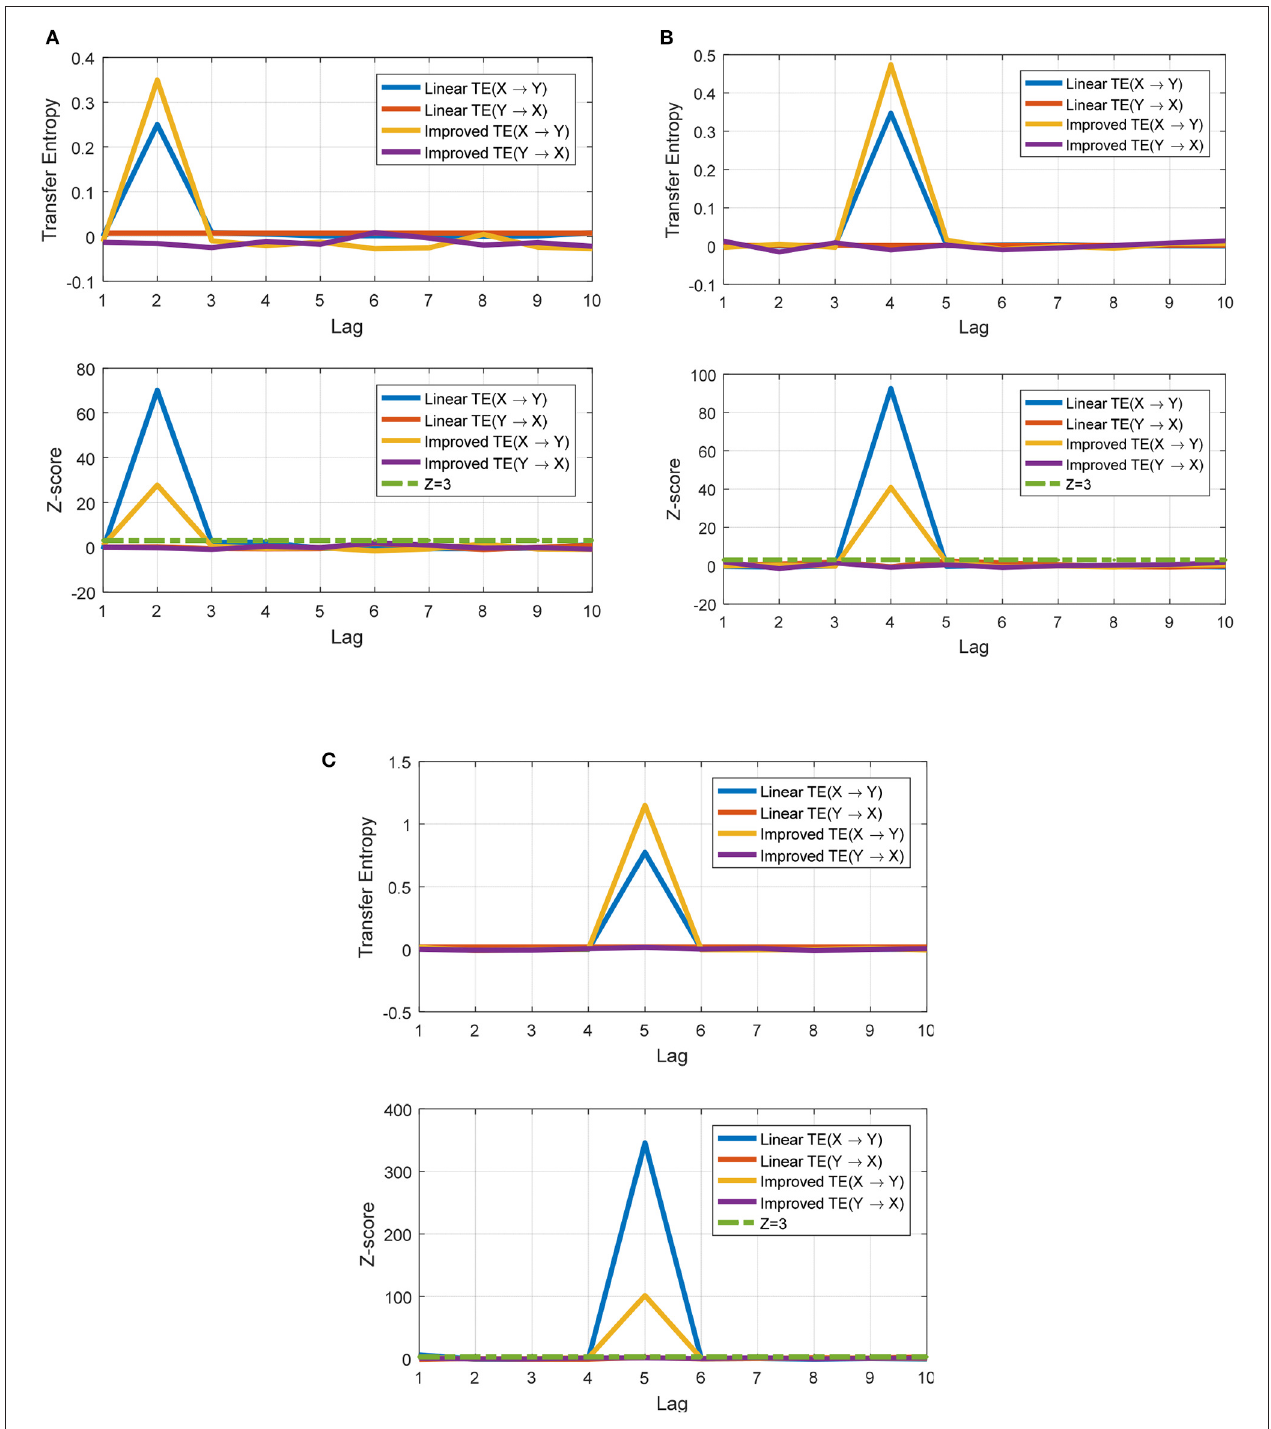
FIGURE 2 | Demonstration that both methods identify the true lag values with maximal transfer entropy. Non-linear transfer entropy is calculated using a quantile-binned histogram, of 6 classes per dimension over 2,500 points. The Z -score for each result is also plotted for both methods. According to the z > 3 principle, it can be concluded that for two time series with a single lag order, the two methods can both identify the lag orders accurately. (A) k = 2, α = 0.5. (B) k = 4, α = 0.5. (C) k = 5, α = 0.5.